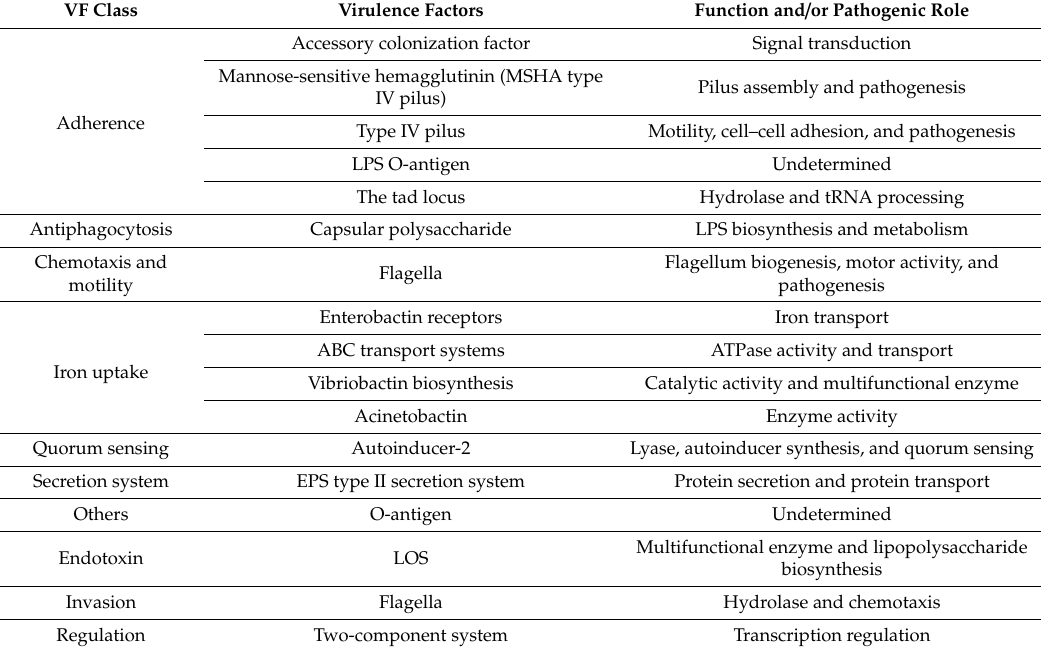
Table 2. Function and pathogenic role of the virulence factors of V. fujianensis FJ201301 T .